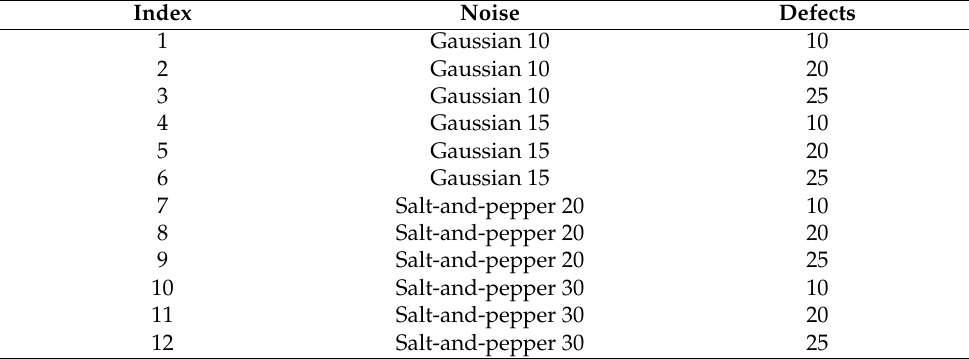
Table 1. Simulated datasets with different settings.